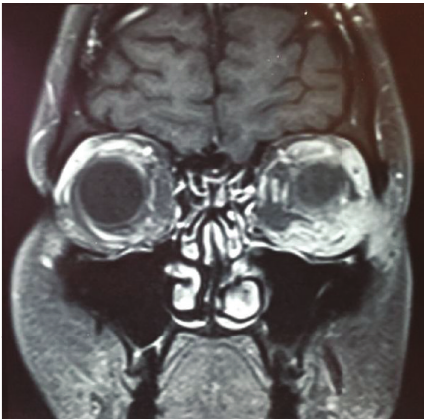
Figure 2: Coronal T1 fat-saturated postgadolinium: solid mass enhancing the gadolinium, located within retroconal, pre- and post- septal, and inferolateral regions.